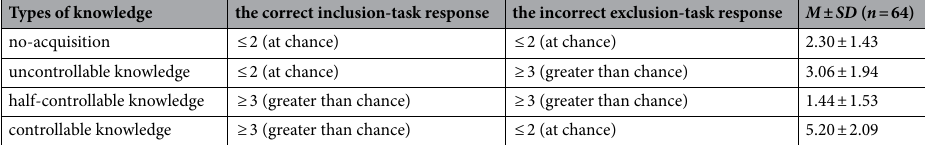
Table 3. The four MET knowledge.